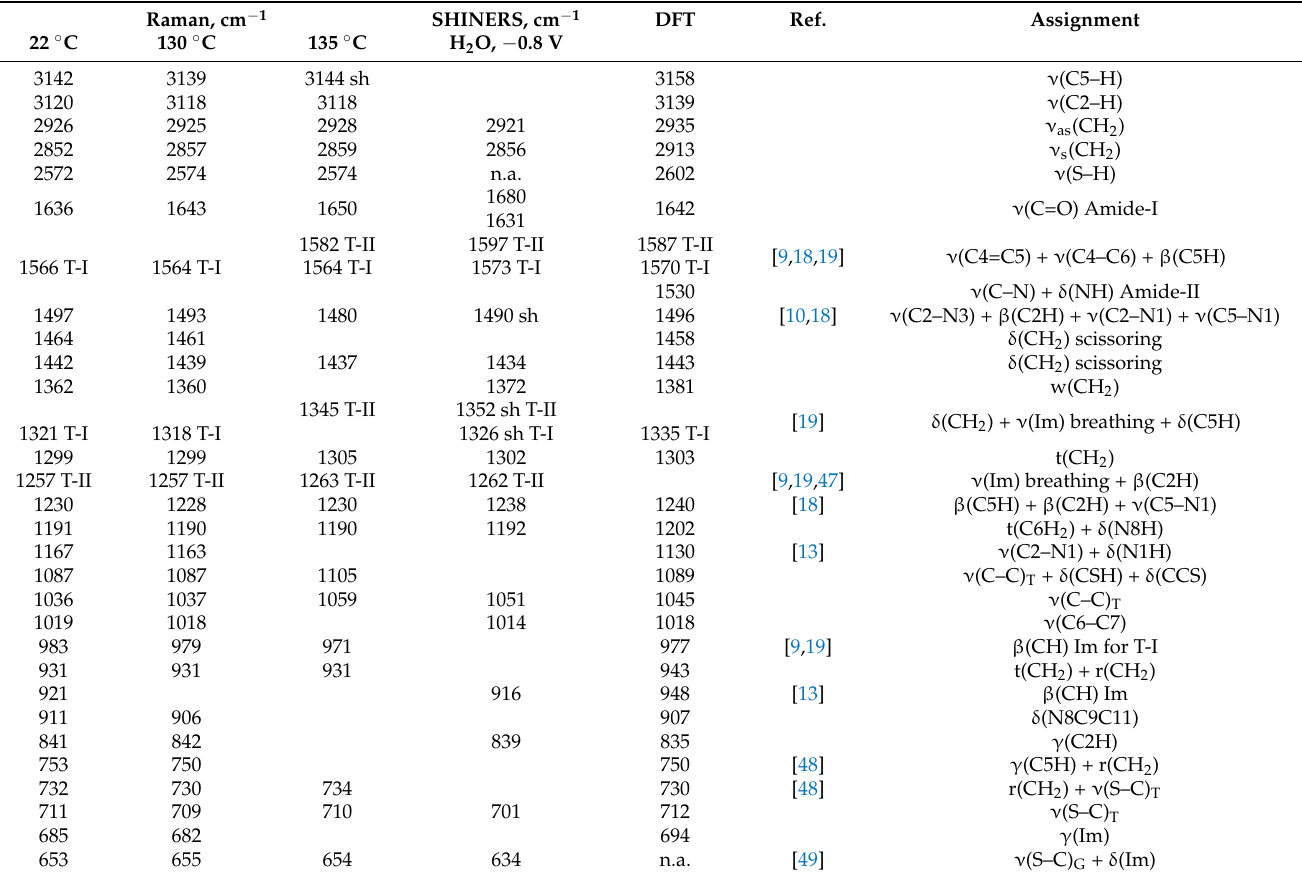
Figure 3. Molecular structure of Tautomer-I and Tautomer-II form of IMHA and the structure of fragment molecule. Table 1. Temperature-Raman, SHINERS, and DFT frequencies and assignments of